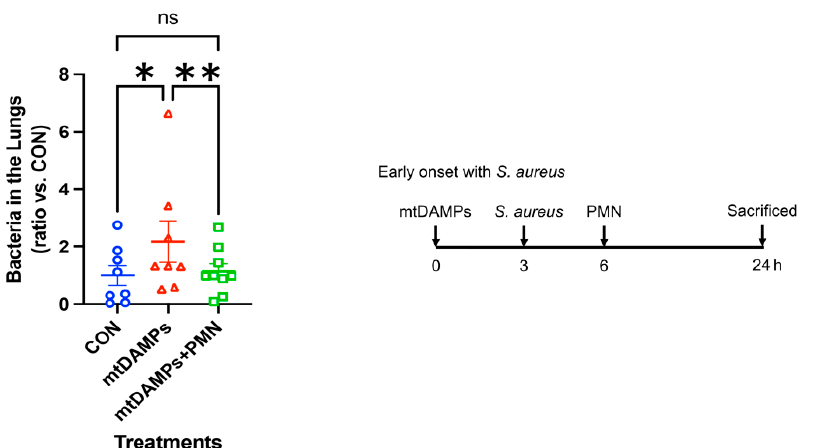
Figure 1. Effects of mtDAMPs and external mouse PMN on S. aureus (SA) clearance in lung. Left: CD-1 mice were separated into three groups. 1. CON: Saline i.p. injection (time 0) followed by S. aureus (3 h) i.t. 2. mtDAMPs: mtDAMPs i.p. followed by S. aureus , 3. mtDAMPs + PMN: mtDAMPs